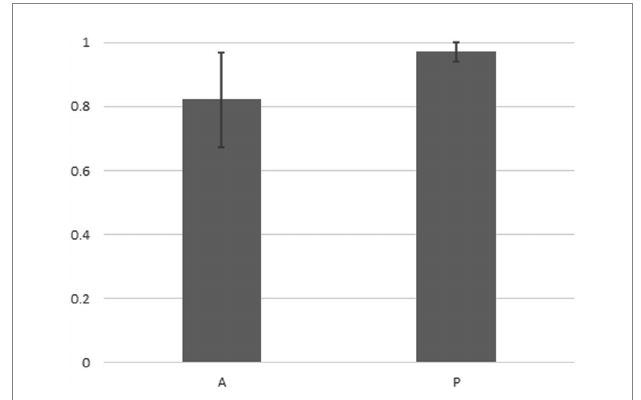
FIGURE 4 Homology analysis of the microbiome composition between bacteria detected from the unfed P. bursaria itself and bacteria detected from the culture medium (LEfSe analysis). The figure shows the mean values of the homology of the eight strains of A (left) and the six strains of P (right) including standard deviation.